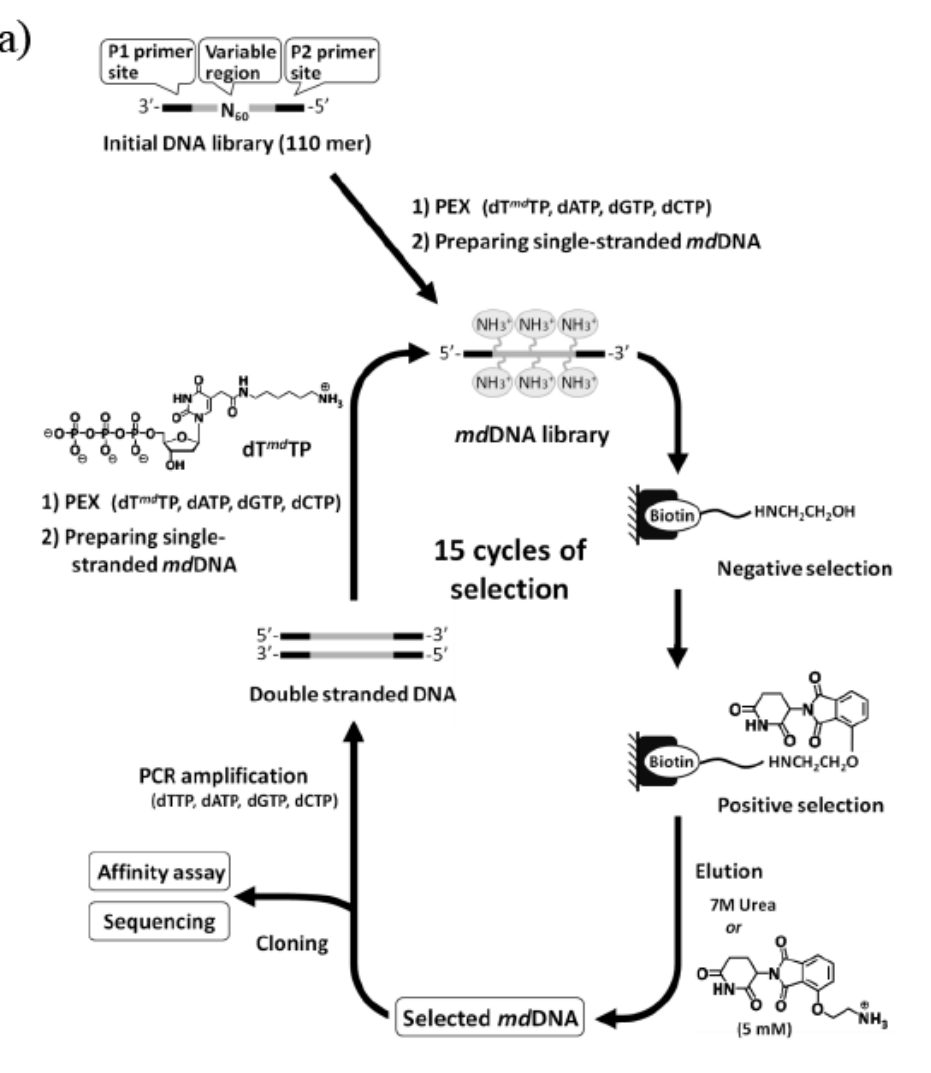
Figure 4. (a) Schematic illustration of in vitro selection of thalidomide-binding modified DNA aptamers. (b) Structure minimization of the obtained modified DNA aptamer based on secondary structure